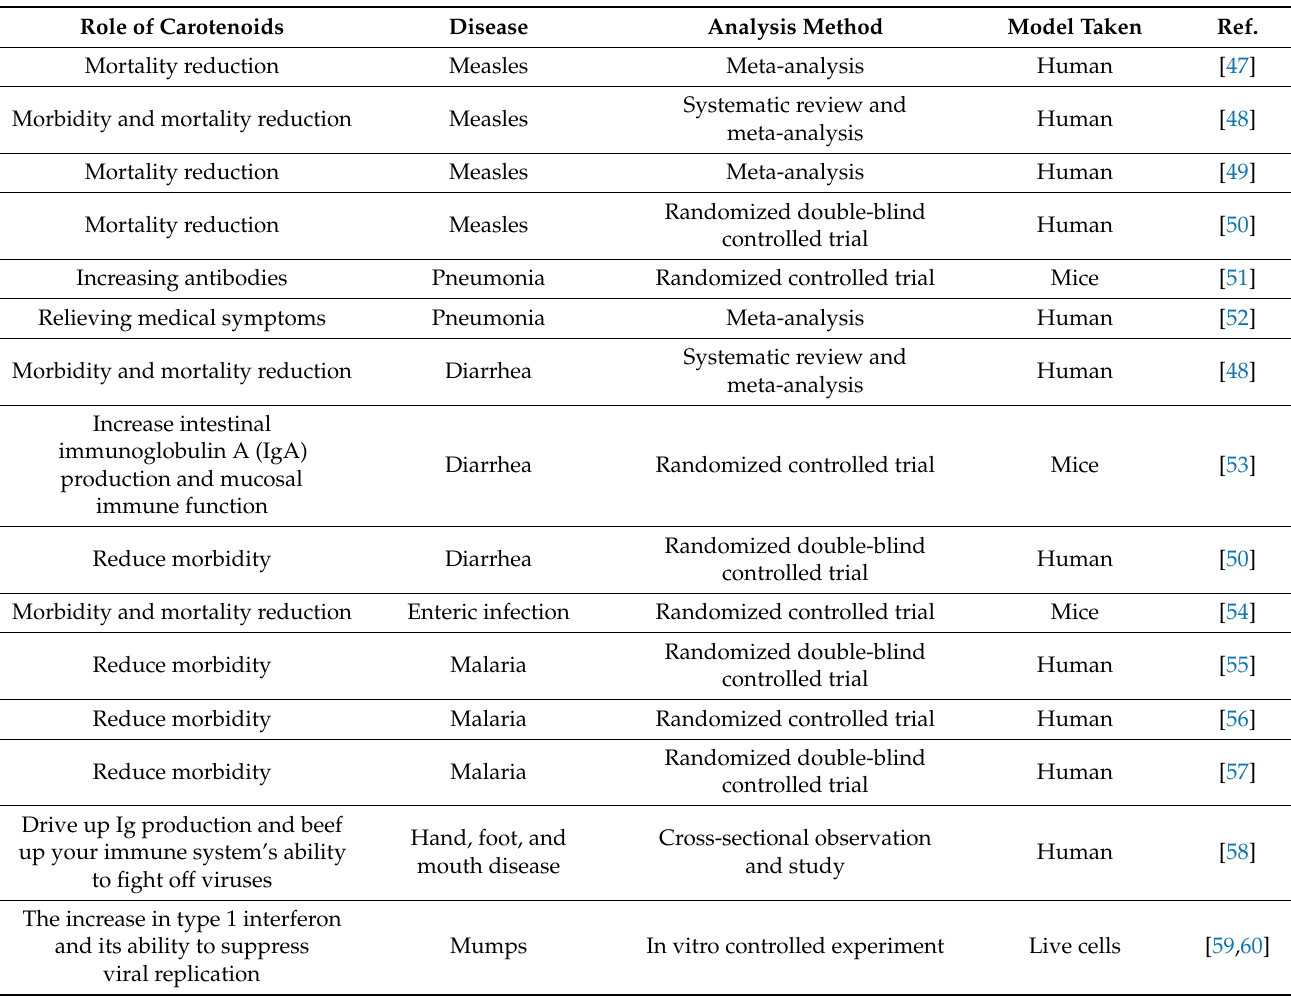
Table 1. Treatment of many contagious childhood illnesses with